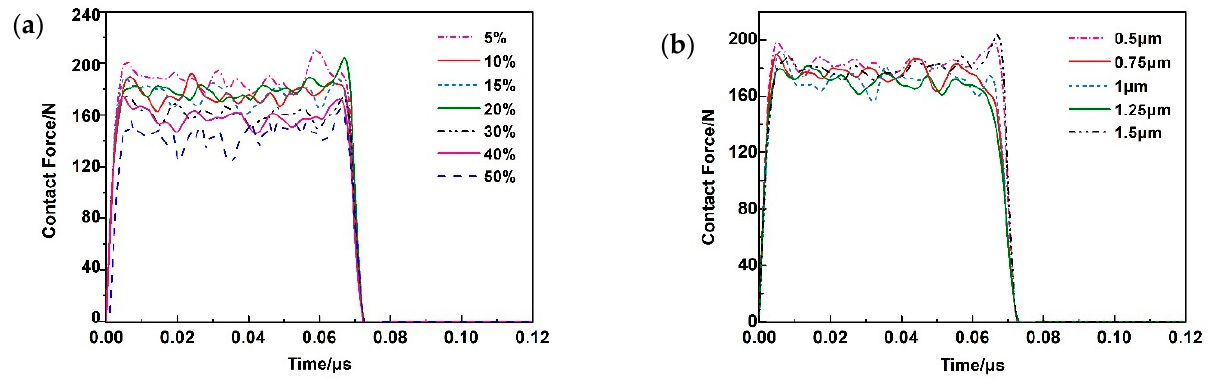
Figure 7. Curves of the scraping contact force with scraping time: ( a ) 1.5 µ m pore diameter, ( b ) 20% porosity.